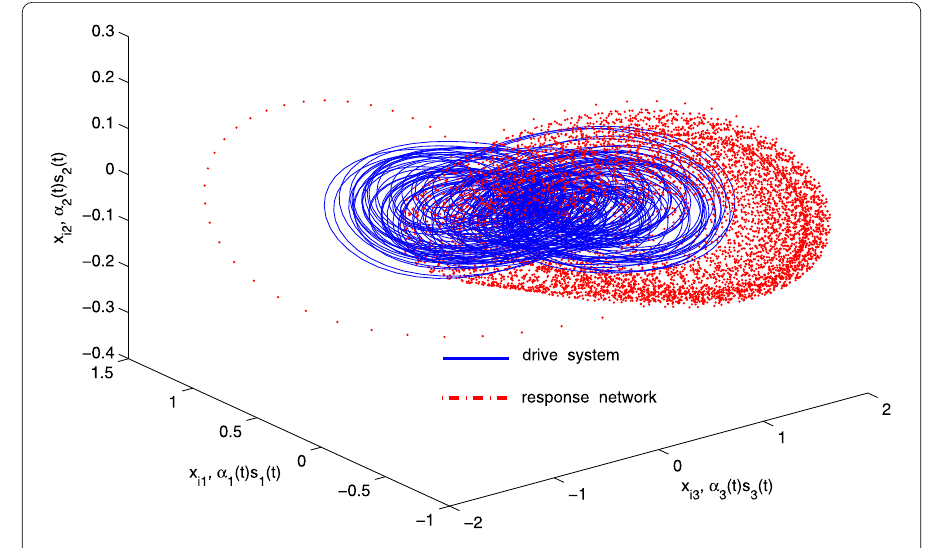
Figure 2 Chaotic behavior of drive system (38) and response network (39) with the time-varying scaling function matrix α ( t ) = diag(0.6sin( 2 π